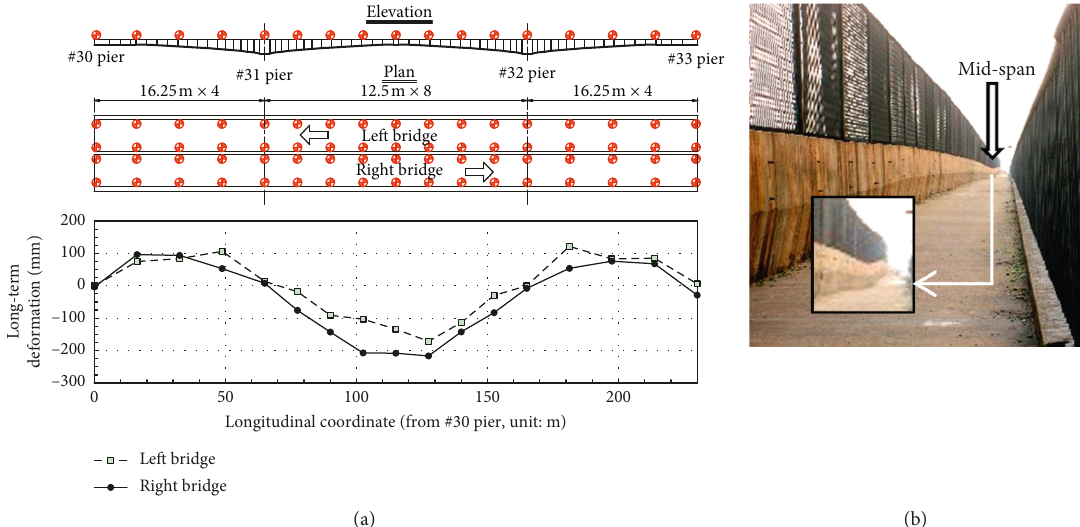
Figure 3: Deformation investigation of the prototype bridge. (a) Investigation points of the deck and long-term deformation over 10 years. (b) Deflection of midspan (pedestrian parapet view). Table 2: Comparison of bending moments of the critical section (unit: kN · m). Section over Bridge span length